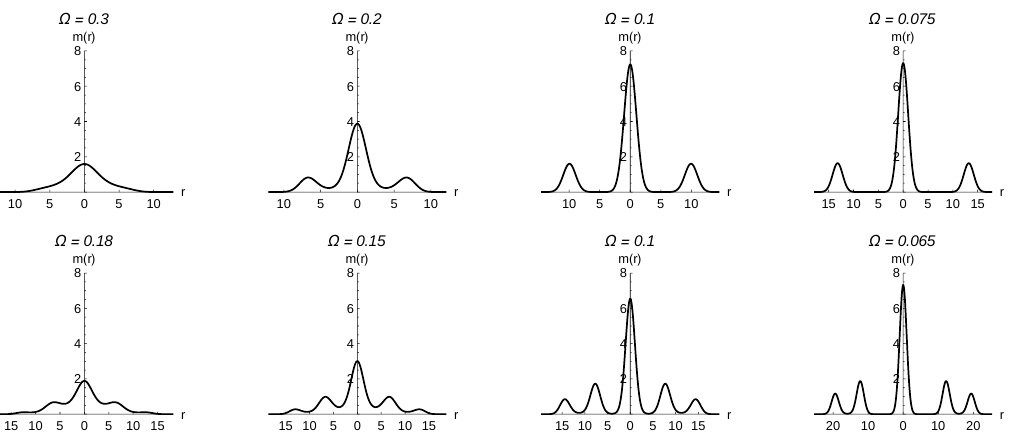
Figure 5 . Cross-sections of the mass density m for black ripples leading to black Saturns corre- sponding to the zero modes N = 3 ; 5 , at di(cid:11)erent values of